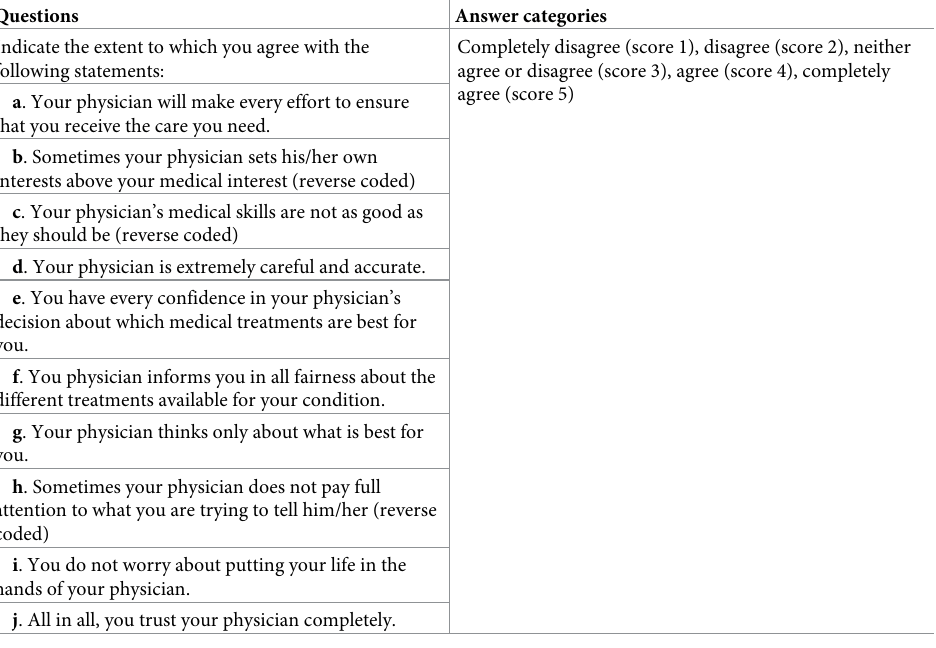
Table 1. Measurement of trust: Wake Forest Physician Trust